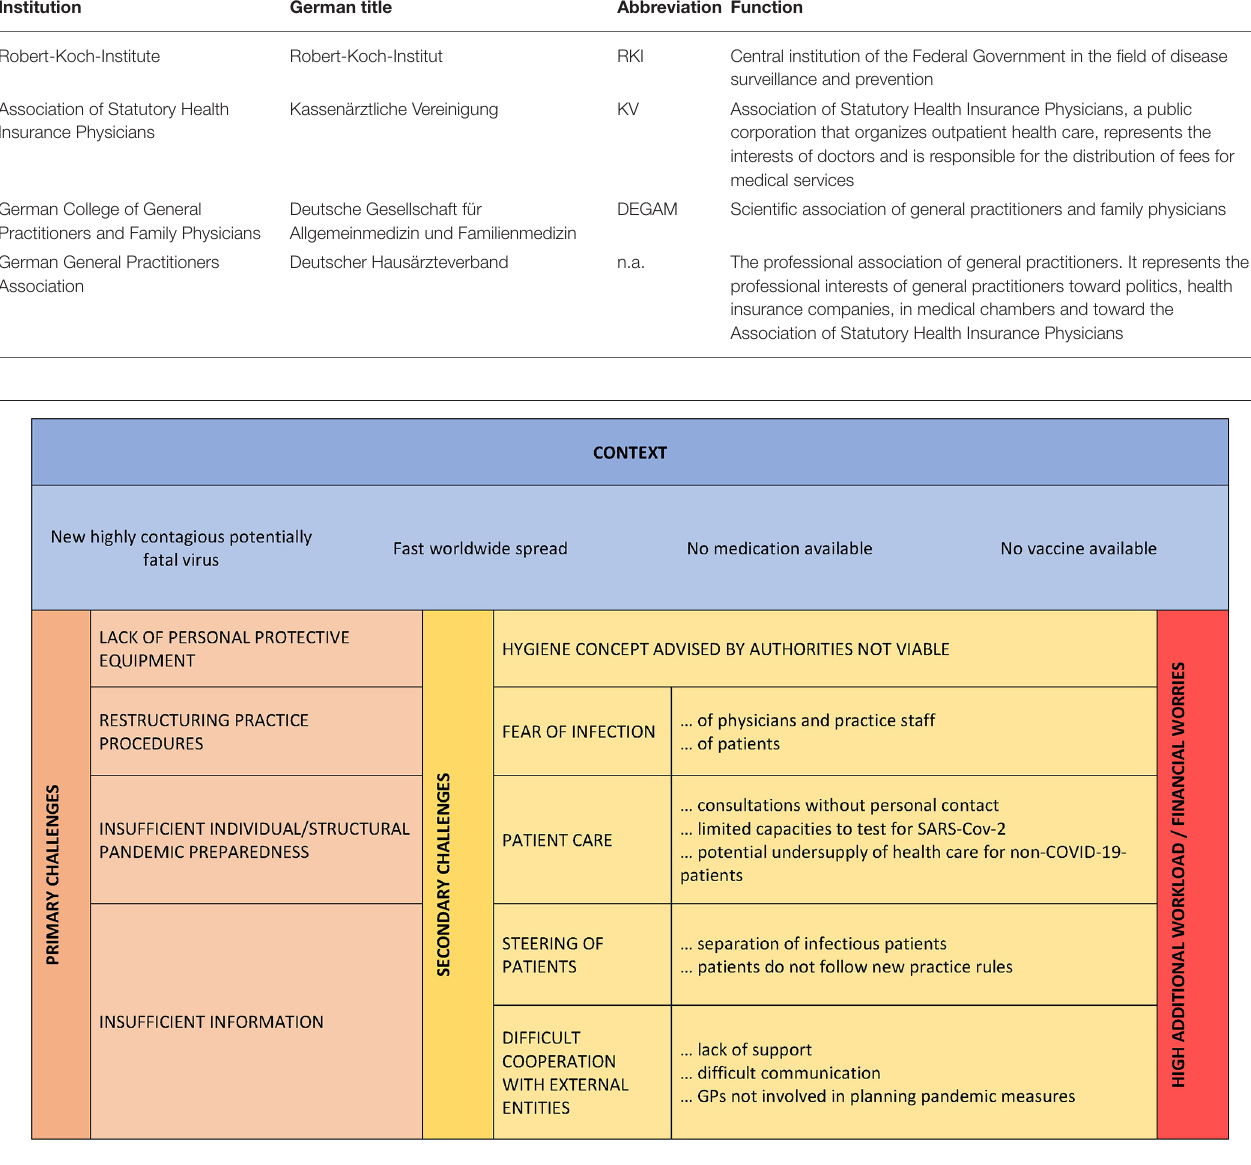
FIGURE 1 | Challenges in primary care during the early phase of the SARS-CoV-2